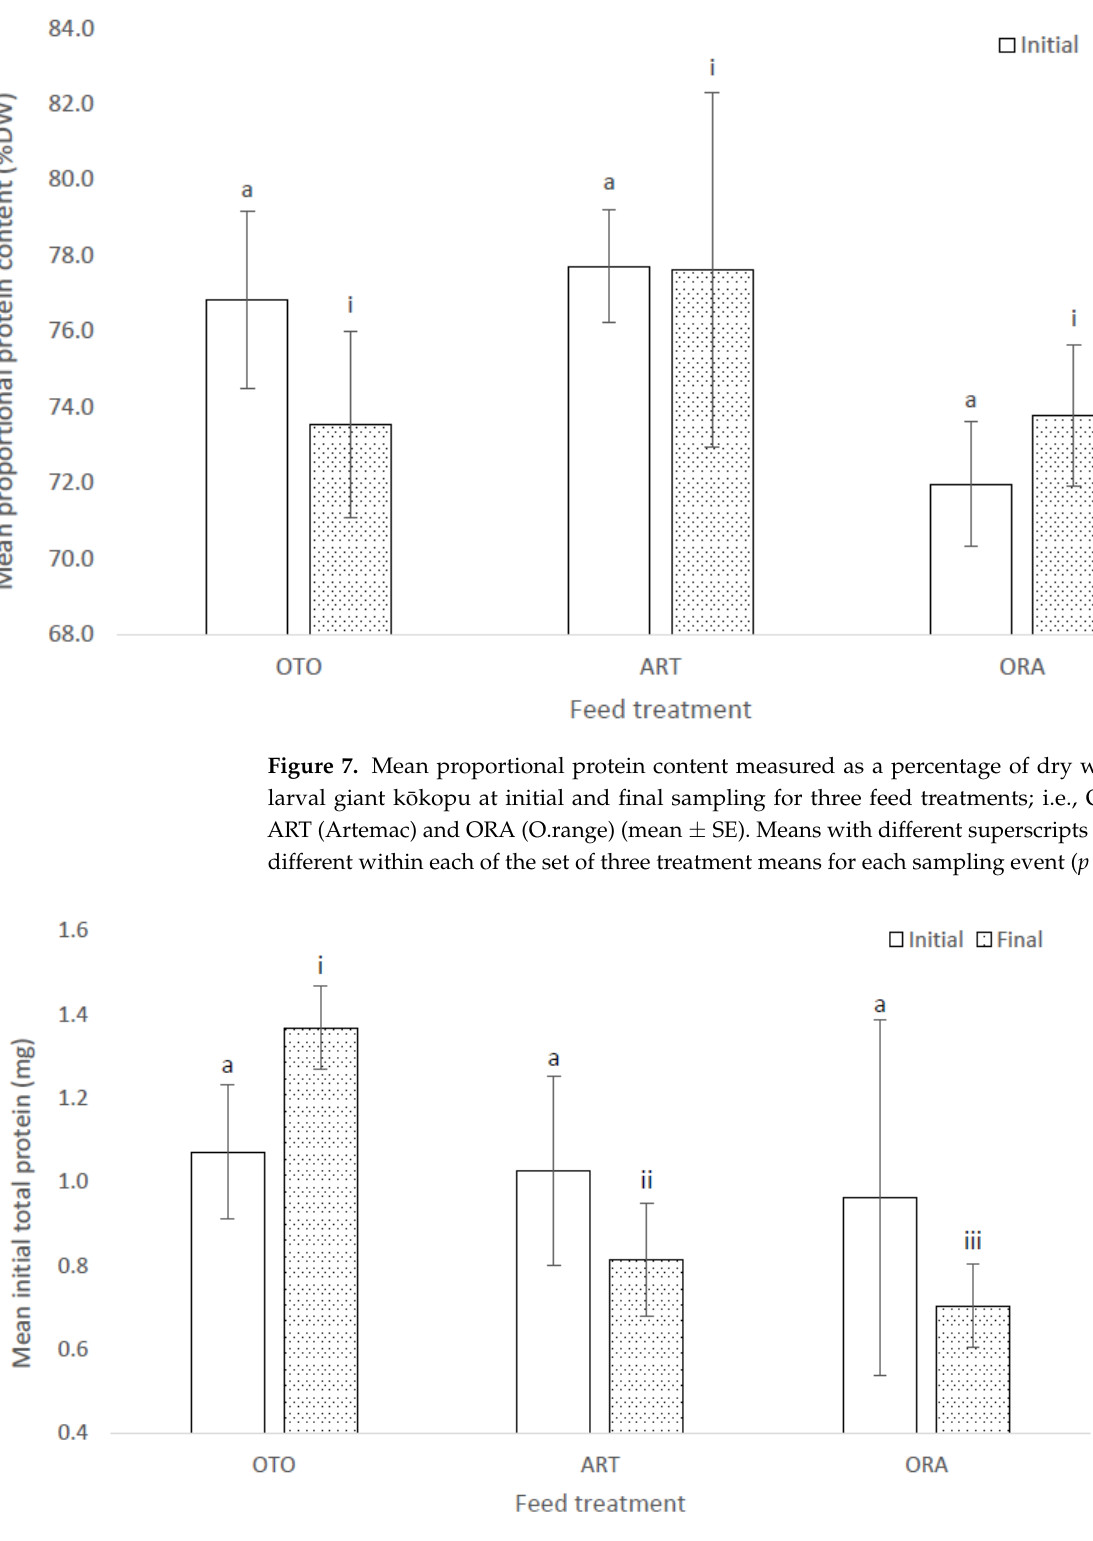
Figure 8. Mean initial and final total protein content of larv al giant kōkopu for three feed treatments; i.e., OTO (Otohime), ART (Artemac) and ORA (O.range) (±SE). Means with different superscripts are significantly different within each of the set of three treatment means for each sampling event ( p < 0.05).